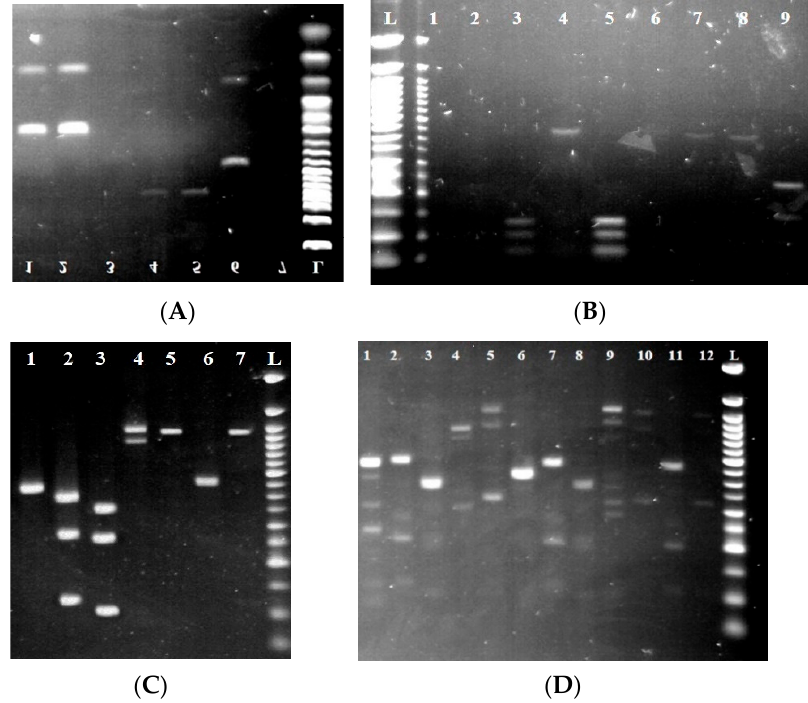
Figure 4. Electropherogram after the digestion of PCR products by restriction endonucleases. ( A ) ( Hae III) L: 50 bp ladder; lines 1–5: isolates Metschnikowia pulcherrima ; lines 4 and 5: isolates Hanseniospora uvarum ; line 6: isolates Candida tenuis . ( B ) ( Hha I) L: 50 bp ladder; lines 3 and 5: isolates Pichia kluyveri ; line 9: Torulaspora delbrueckii . ( C ) ( Mse I) L: 50 bp ladder; lines 2 and 6: isolates Pichia kudriavzevii ; line 3: isolates Pichia fermentas . ( D ) ( Hinf I) L: 50 bp ladder; line 1: isolates Pichia fermentas ; lines 2 and 11: isolates Metschnikowia pulcherrima ; lines 3, 8, 10, and 12: isolates Saccharomyces cerevisiae .